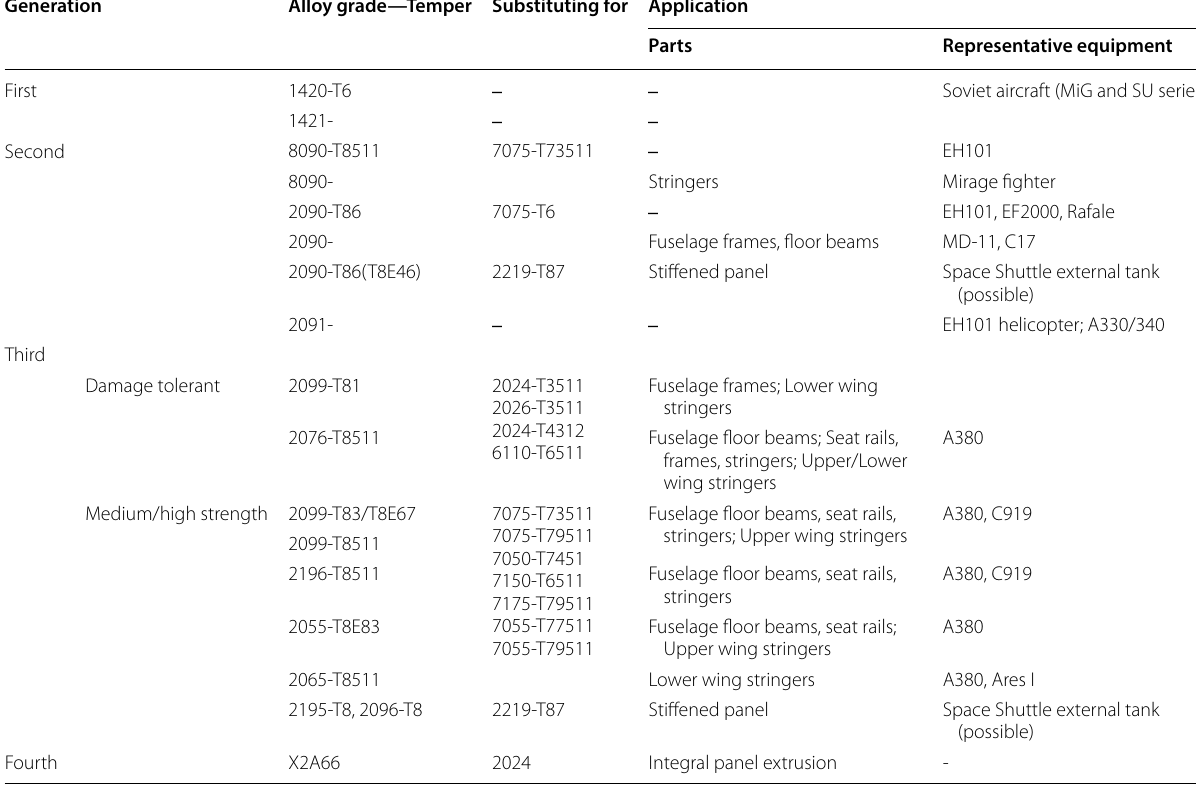
Table 1 Applications of Al–Li alloy extrusion profiles and the replaced aluminum alloys [1–3, 5, 10, 17–19] Generation Alloy grade—Temper Substituting for